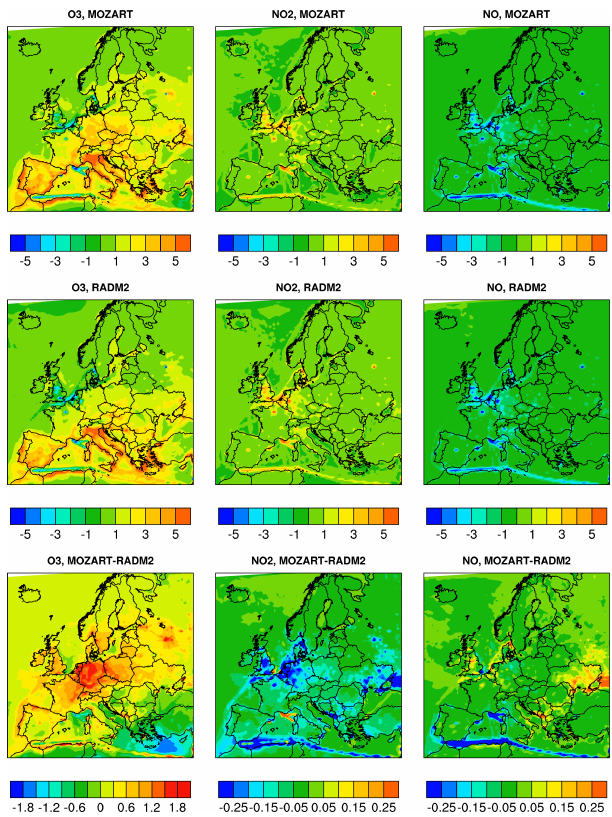
Figure 15. Net midday (11:00–14:00CEST) surface photochem- ical production rate in ppbh − 1 for O 3 , NO 2 , and NO shown for MOZART and RADM2 for July 2007. The last row shows the dif- ference in net production rate in ppbh − 1 (RADM2 subtracted from MOZART).